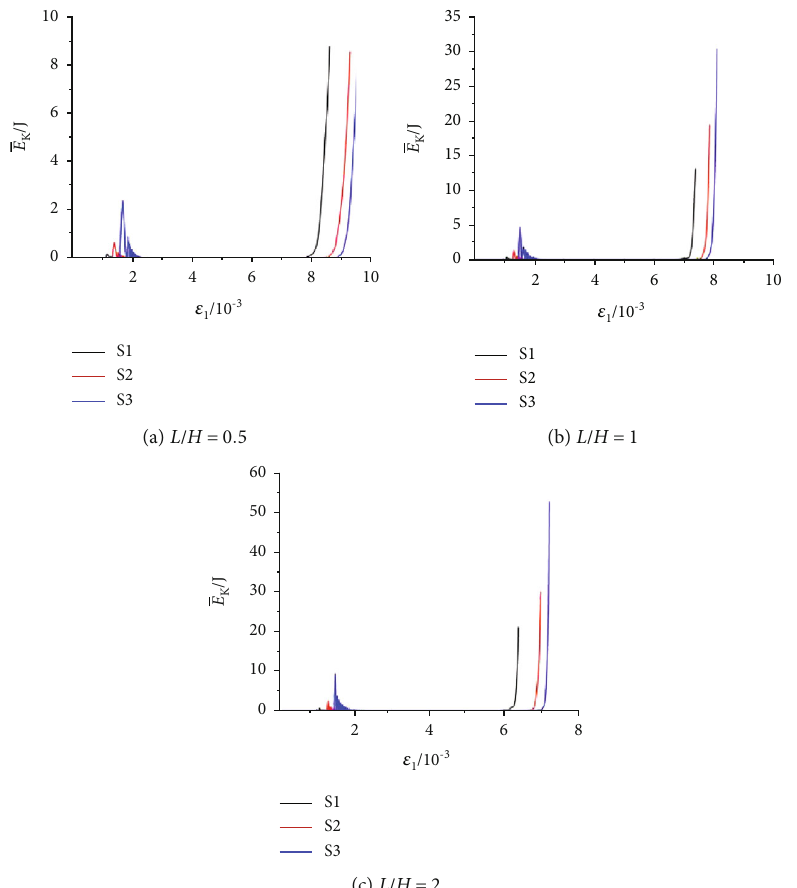
Figure 7: Curves of the kinetic energy